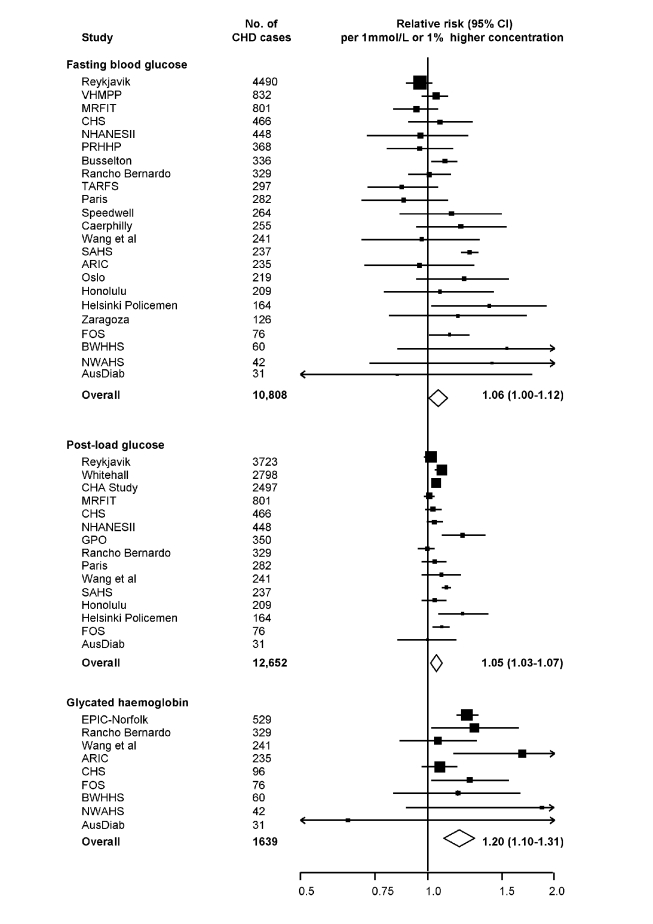
Prospective studies of markers of dysglycaemia and CHD risk in individuals without diabetes in Western populations.Analyses were restricted to individuals who did not have a self-reported history of type 2 diabetes or had a fasting blood glucose <7.0 mmol/l at baseline. Risk estimates are presented per 1 mmol/l higher fasting and post-load glucose, and per 1% higher HbA1c. Abbreviations as listed in Table S2.